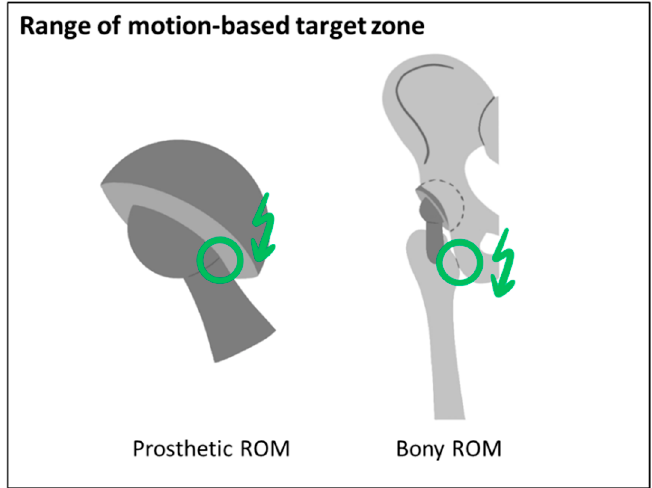
Figure 3. Criteria considered for the ROM-based target zone.